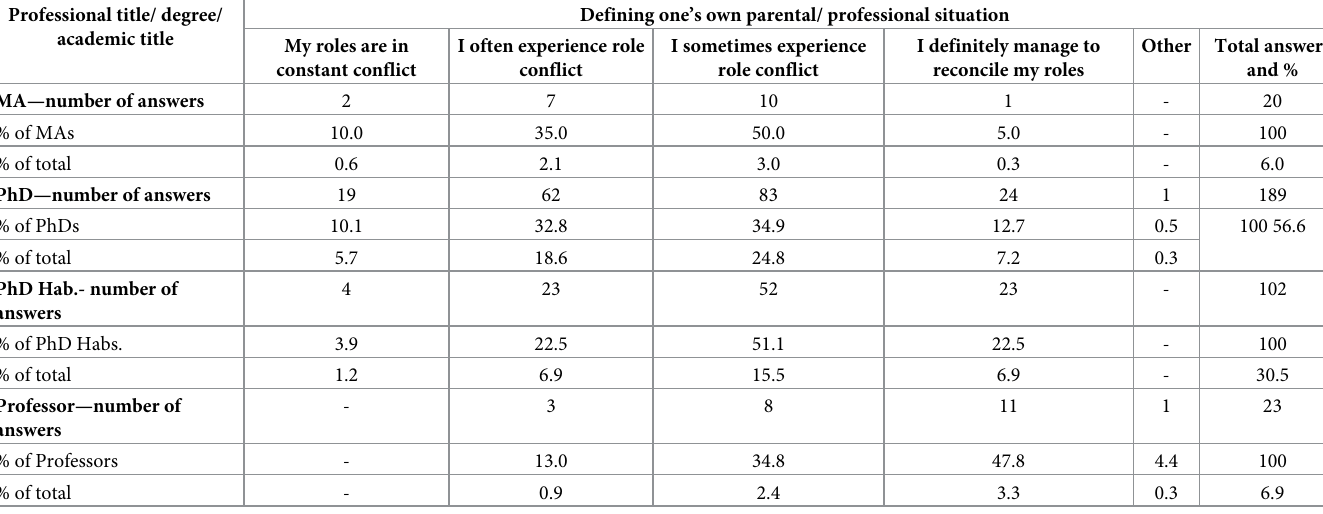
Table 9. Conflict of scientific career vs. motherhood in the opinion of mothers of female scientists by professional title/degree/title. Source: Study by E. Krause. Professional title/ degree/ academic